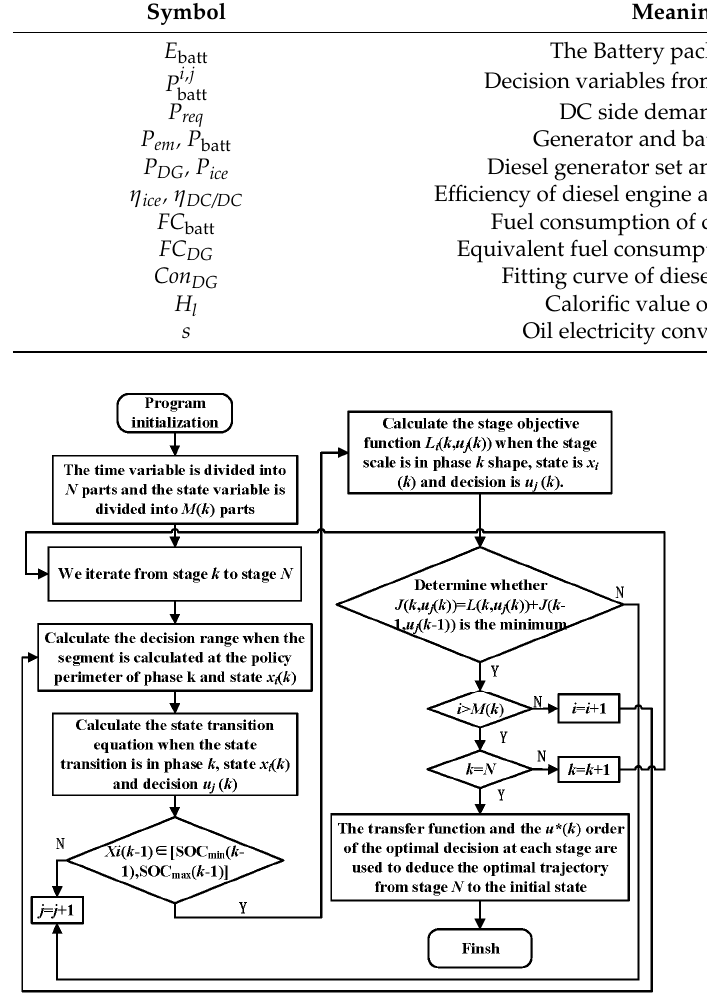
Figure 8. DP strategy flow block diagram.